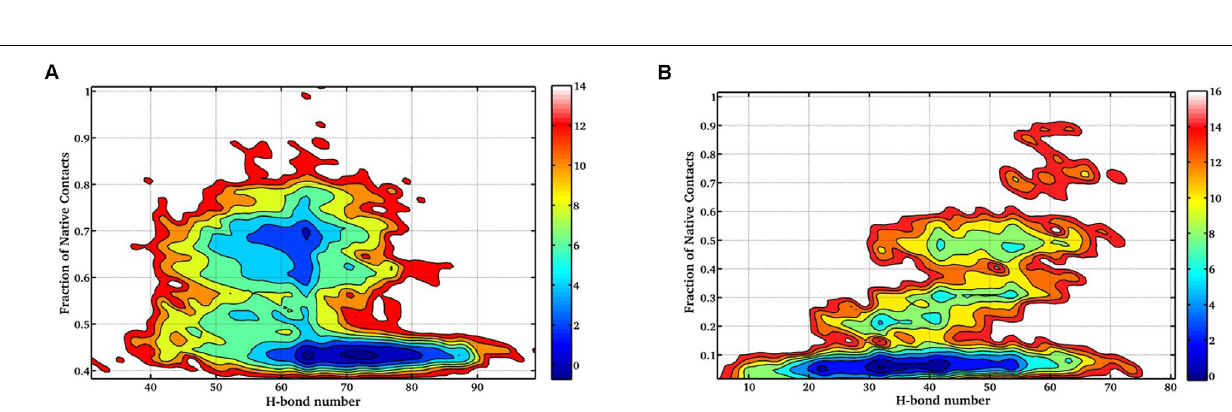
FIGURE 4 | FEL of the number of intraprotein H- bonds vs. the number of native contacts at (A) 400 K, and (B) 450 K. The results clearly indicate the large decrease in the number of H-bonds at a higher